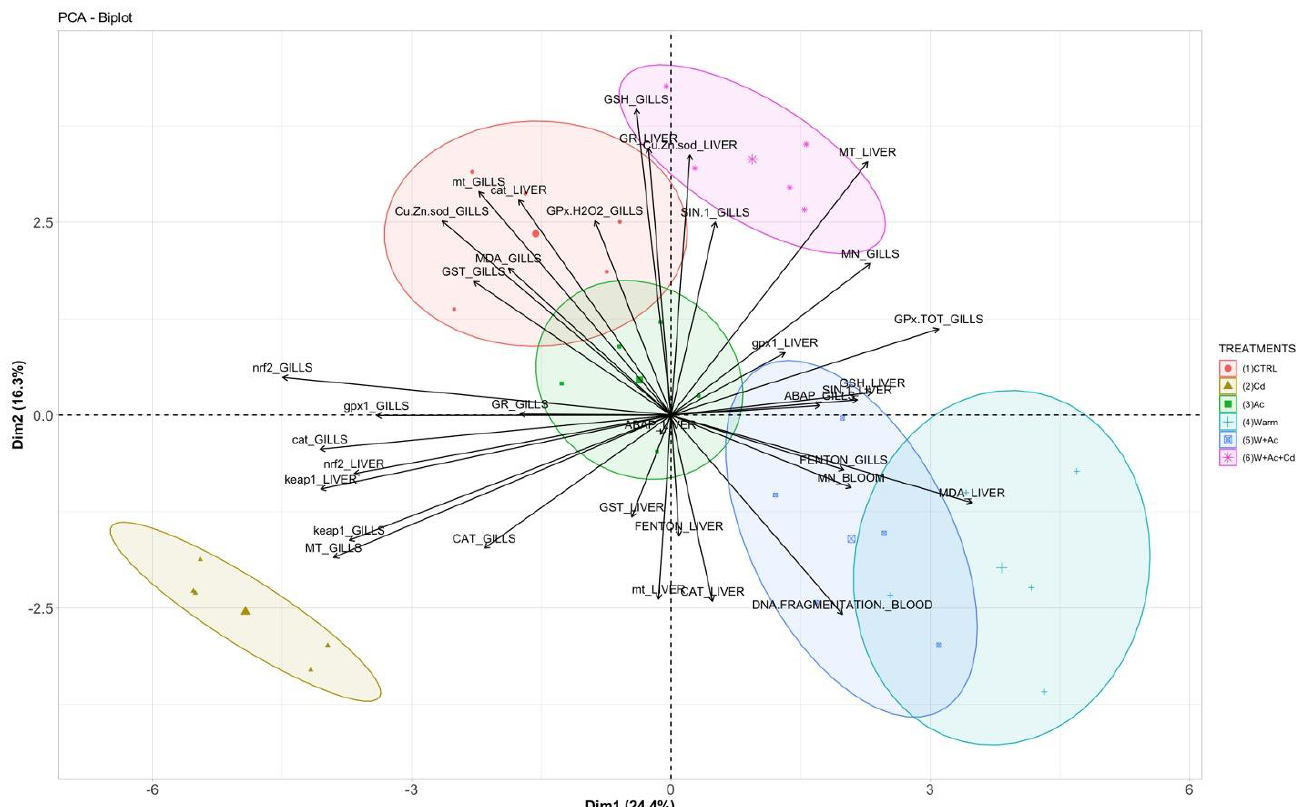
Figure 7. Graphical representation of principal component analysis conducted on the whole dataset of biological parameters.